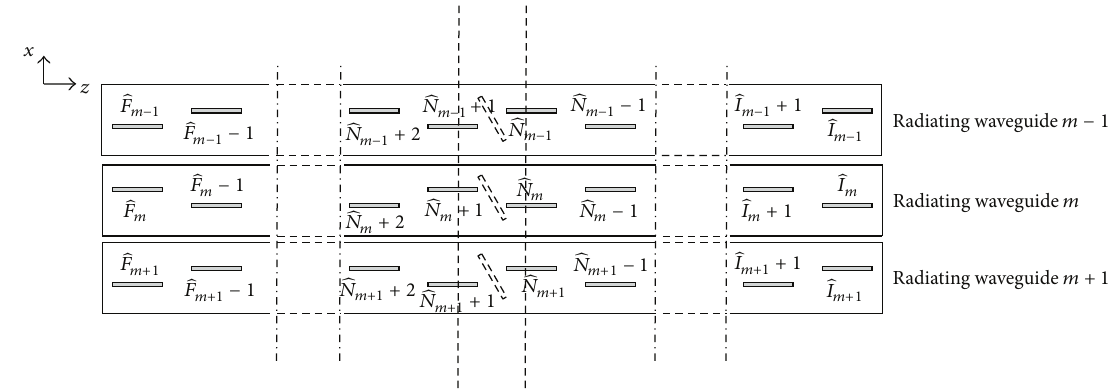
Figure 2: Radiating slots